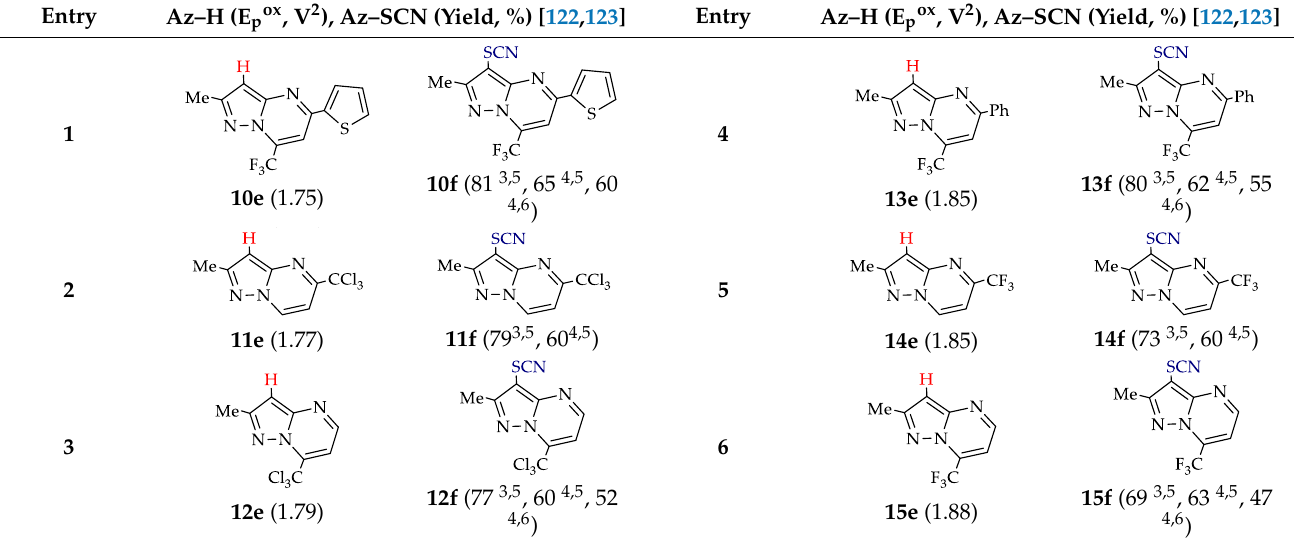
for the isolated and purified products; 2 it was determined by CV (working electrode — Pt, reference electrode — SCE, ν = 0.10 V ‧ s −1 ); 3 Approach B: KSCN (4 mmol), ZnCl 2 (2 mmol), pyrazole (1 mmol), CPE (E anode = 1.00 V), Q t =193 C, Q/Q t = 3; 4